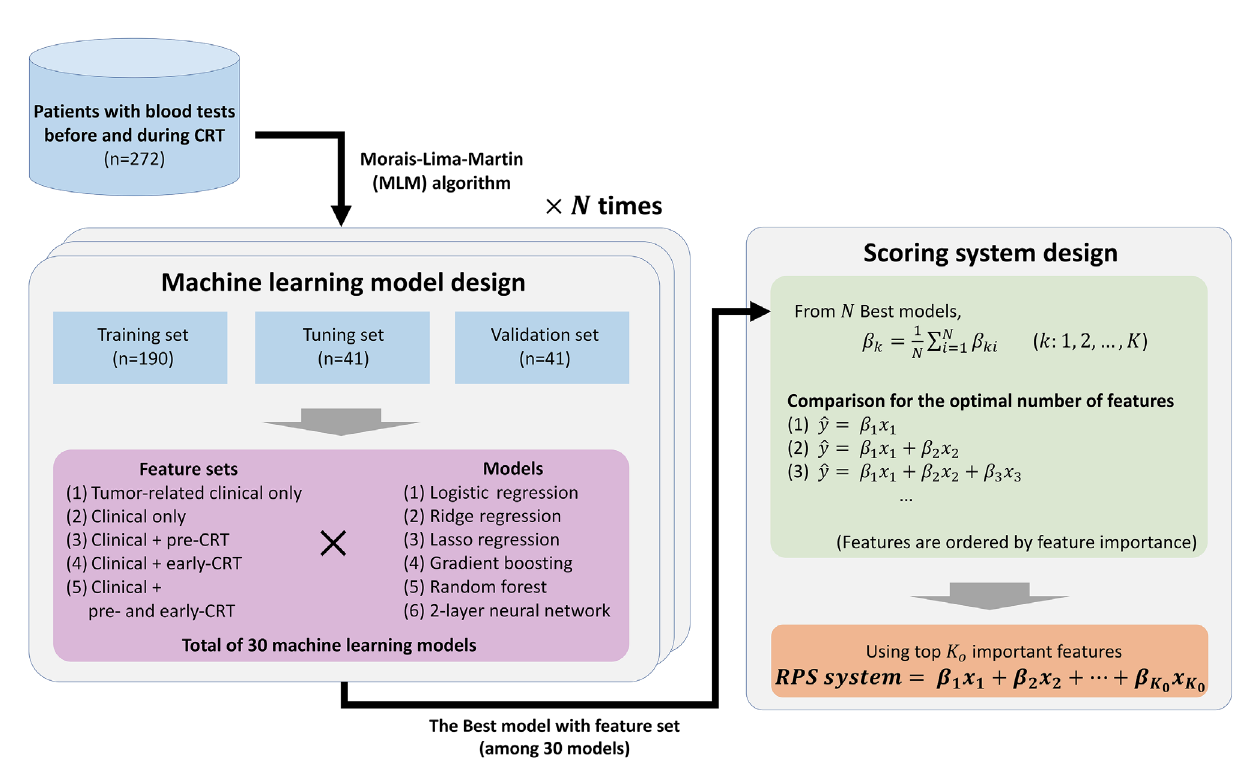
FIGURE 1 | Overview of the entire study. The best model is selected by evaluating possible machine learning models with N repeats, and a novel scoring system with signi fi cant predictive power and simplicity is designed using the N best models. The order of important features is determined based on generalized feature importance ( b k ), and signi fi cance of score candidates are compared to fi nd the optimal number of important features ( K o